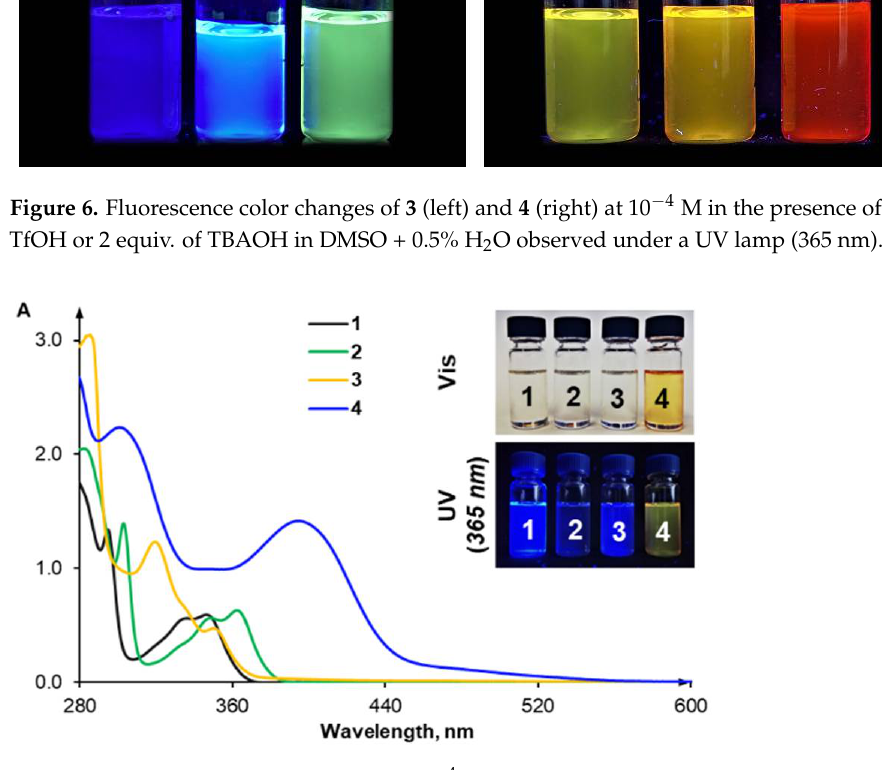
(b) (b) Figure 8. Color changes of 10 -4 M solutions of 3 and 4 in the presence of 10 equiv. of various anions (added as TBA salts) in DMSO + 0.5% H 2 O: ( a ) under ambient light and ( b ) under a UV lamp (365 nm).